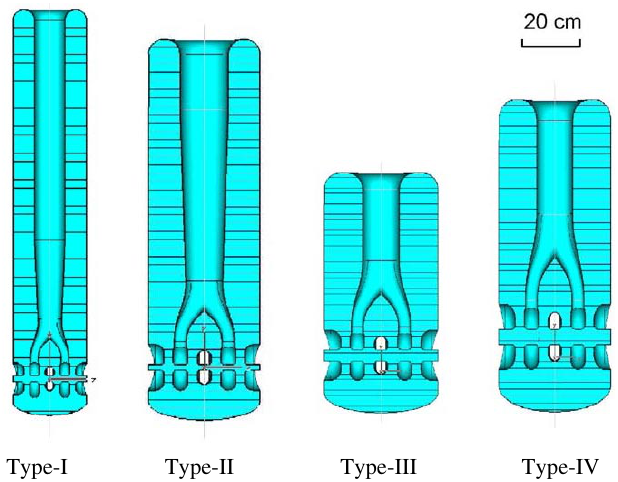
FIG. 3. (Color) MWS models of four types of 4-gap quarter-wave resonators.